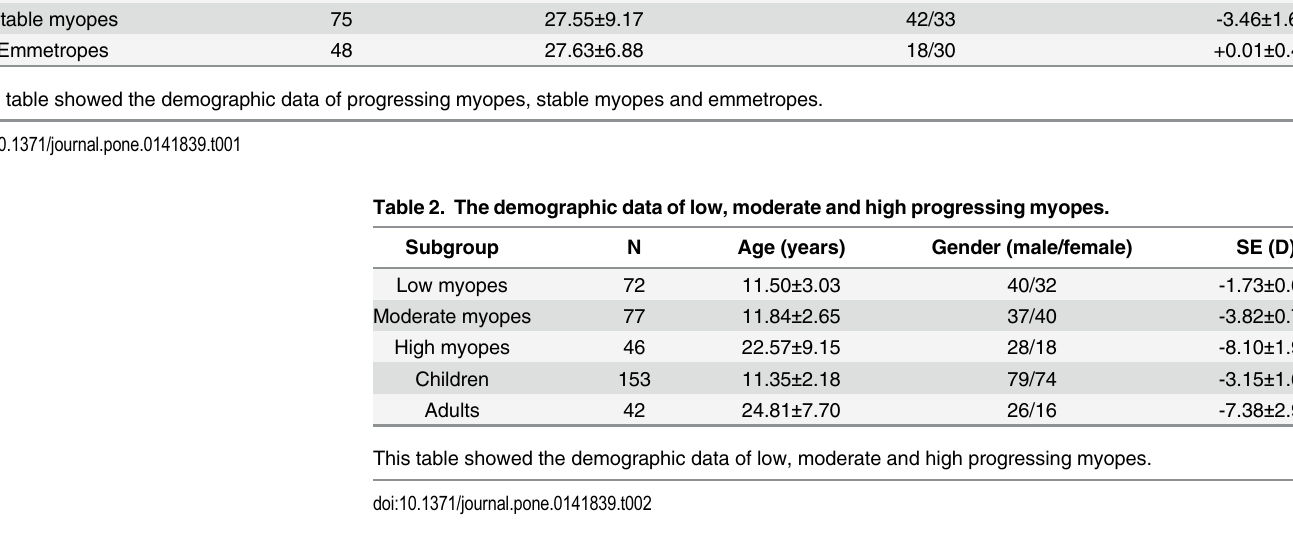
Table 1. The demographic data of progressive myopes, stable myopes and emmetropes. Group N